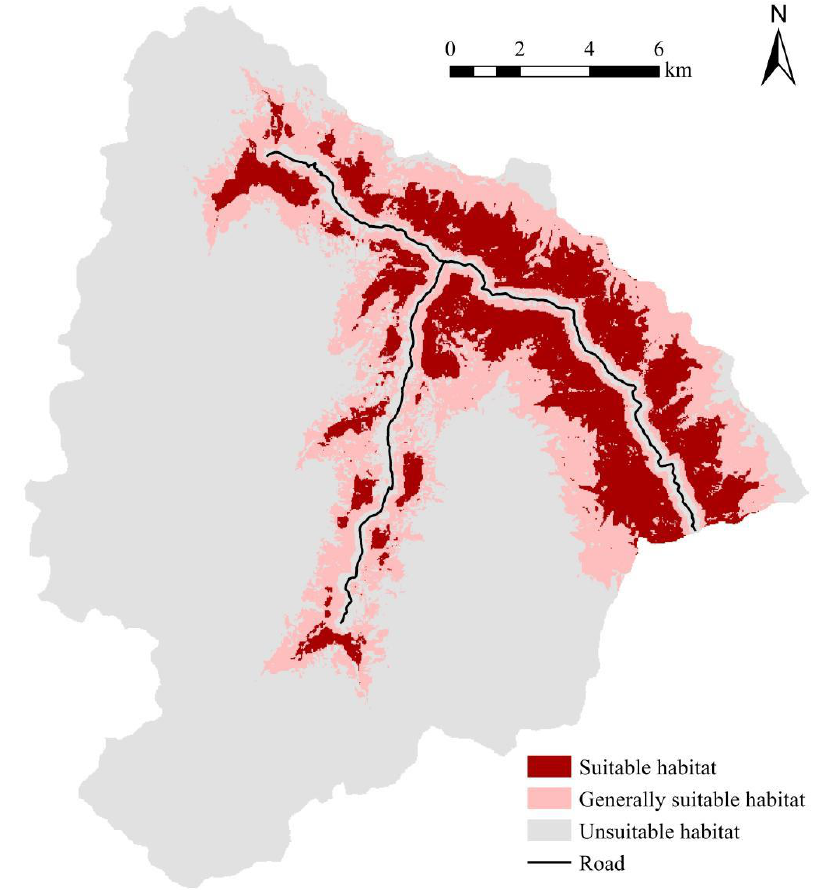
Figure 2. Suitability map of resting habitats in the Wanglang Nature Reserve.